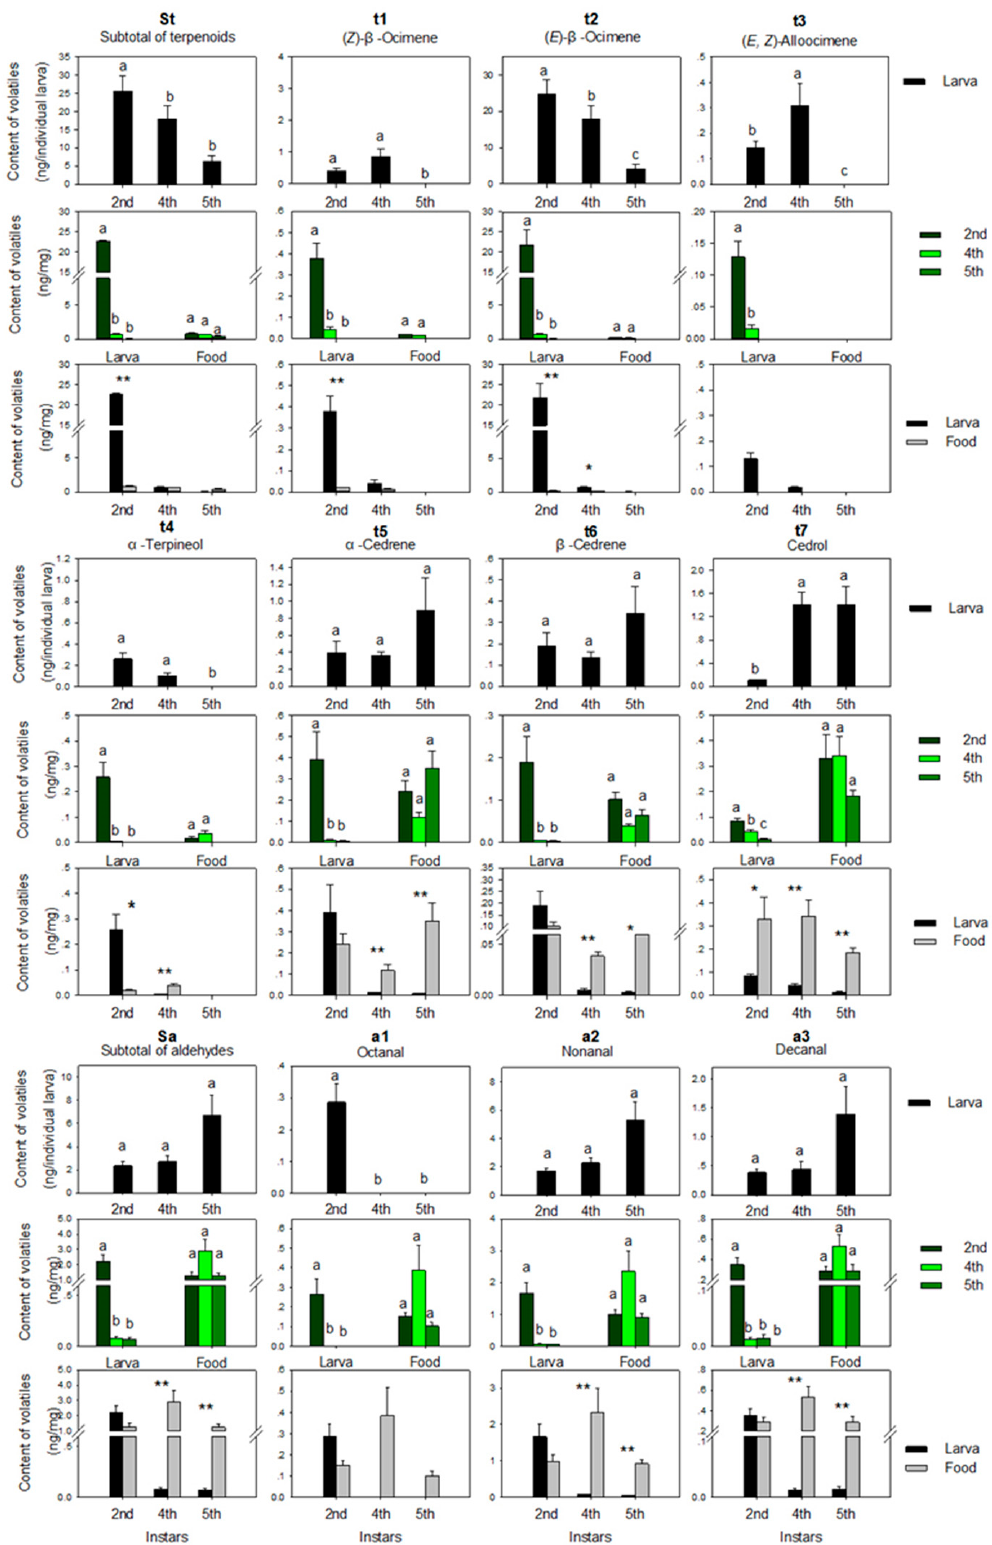
Figure 3. Terpenoids and aldehydes extracted from larvae and larval food at di ff erent larval instars. N > 10 for each group; error bars represent standard errors, di ff erent letters and ‘*’ on top of bars denote significant di ff erence at the level of 0.05, ‘**’ at the level of 0.01 under Fisher’s PLSD test, after ANOVA showed a significant e ff ect. Bars sharing a superscript letter are not significantly di ff